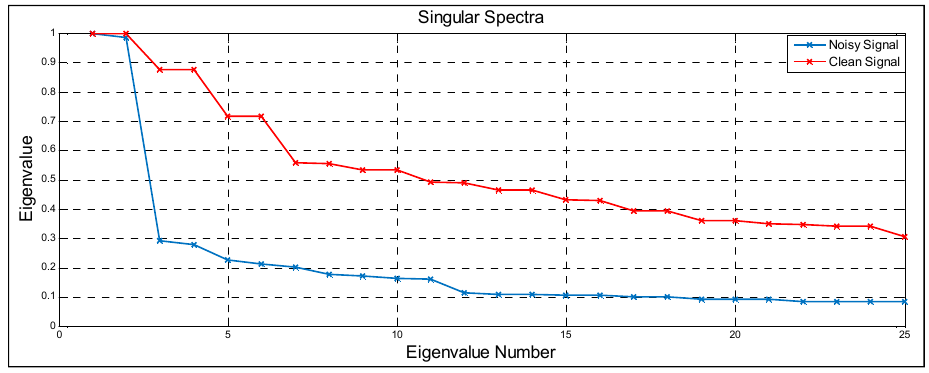
Figure 7. Singular spectra of clean record of birds’ chirps and a noisy one with wind noise added.